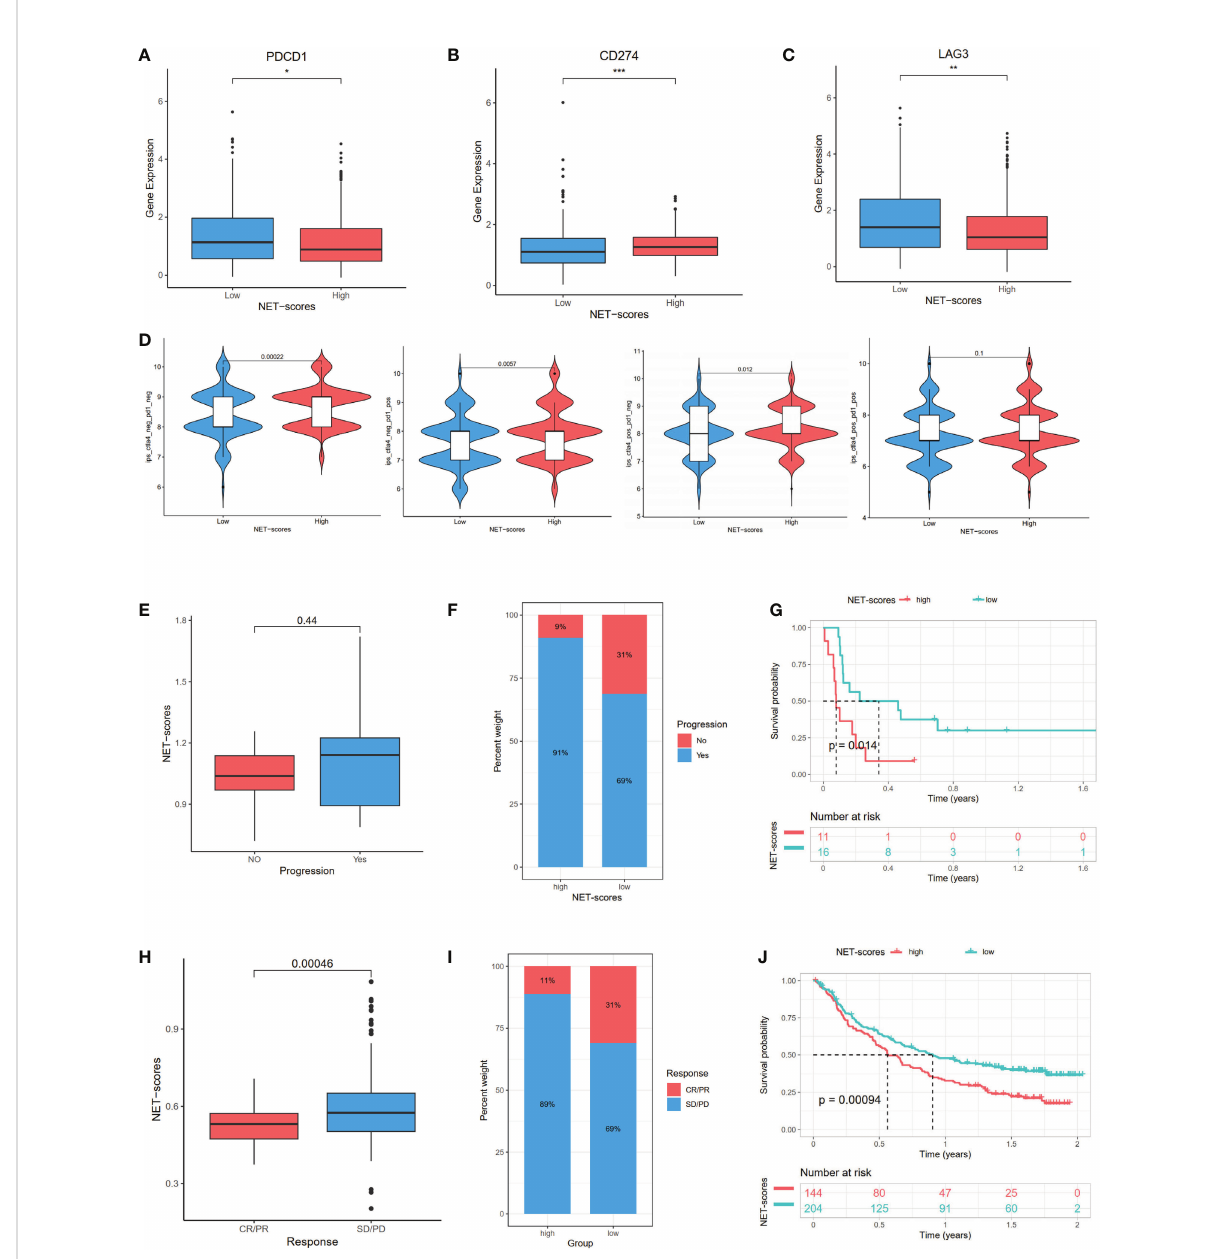
FIGURE 7 The mRNA expression of immune checkpoint genes and immunotherapeutic bene fi ts. The PDCD1 (A) , LAG3 (B) , and CD274 (C) expression between different NET-score groups. The association between IPS and NET scores (D) . The different immunotherapy responses between high- and low-NET-score groups in GSE135222 (E – G) and IMvigor210 (H – J) datasets. *p < 0.05, **p < 0.01, ***p <